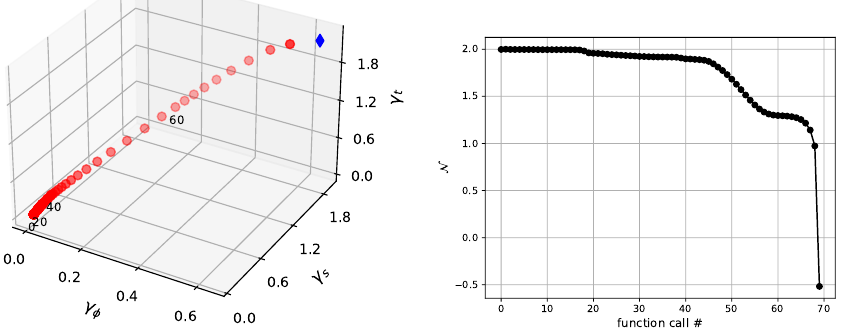
Figure 14: BFGS run for N = 2, d = 3.7 at Λ = 19 using as the initial guess the min- imum of the run at d = 3.8. Red points are disallowed, blue diamonds are allowed. From the monotonic increase of γ φ , γ misses the (tiny) island and runs off to the